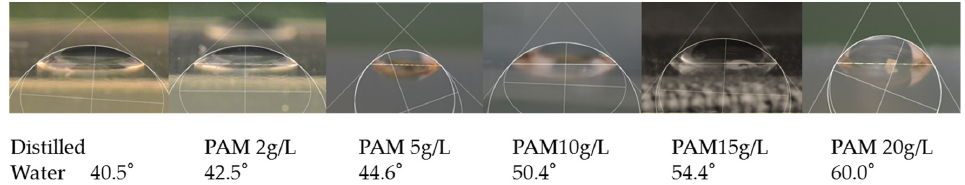
Figure 5. Contact angles at various PAM concentrations on the silica surface in air.